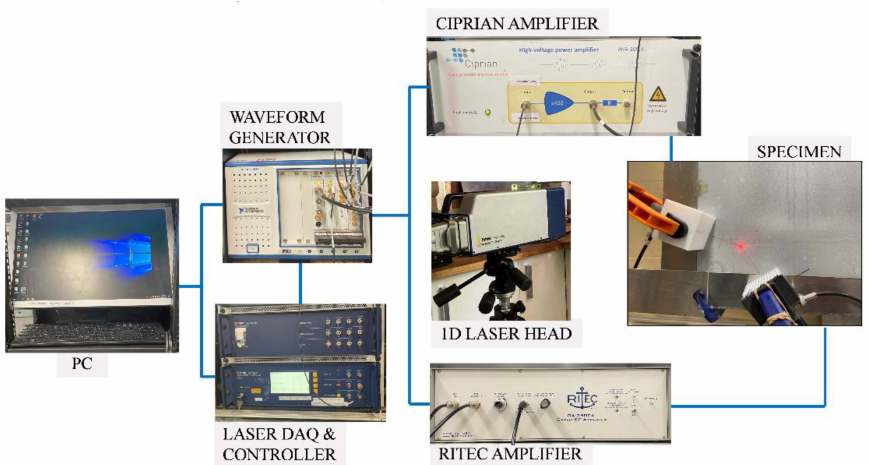
Figure 5. Experimental